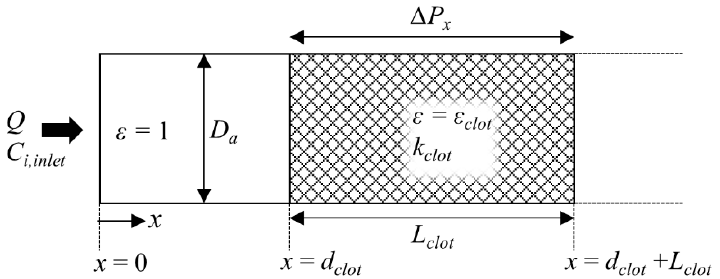
Figure 2. Schematic of 1D blood flow and species transport model. The entrance of the blocked artery corresponds to the bifurcating point where flow splits into two branches. The shaded area represents the clot with a porosity of ε clot and the open area is clot-free with ε = 1.